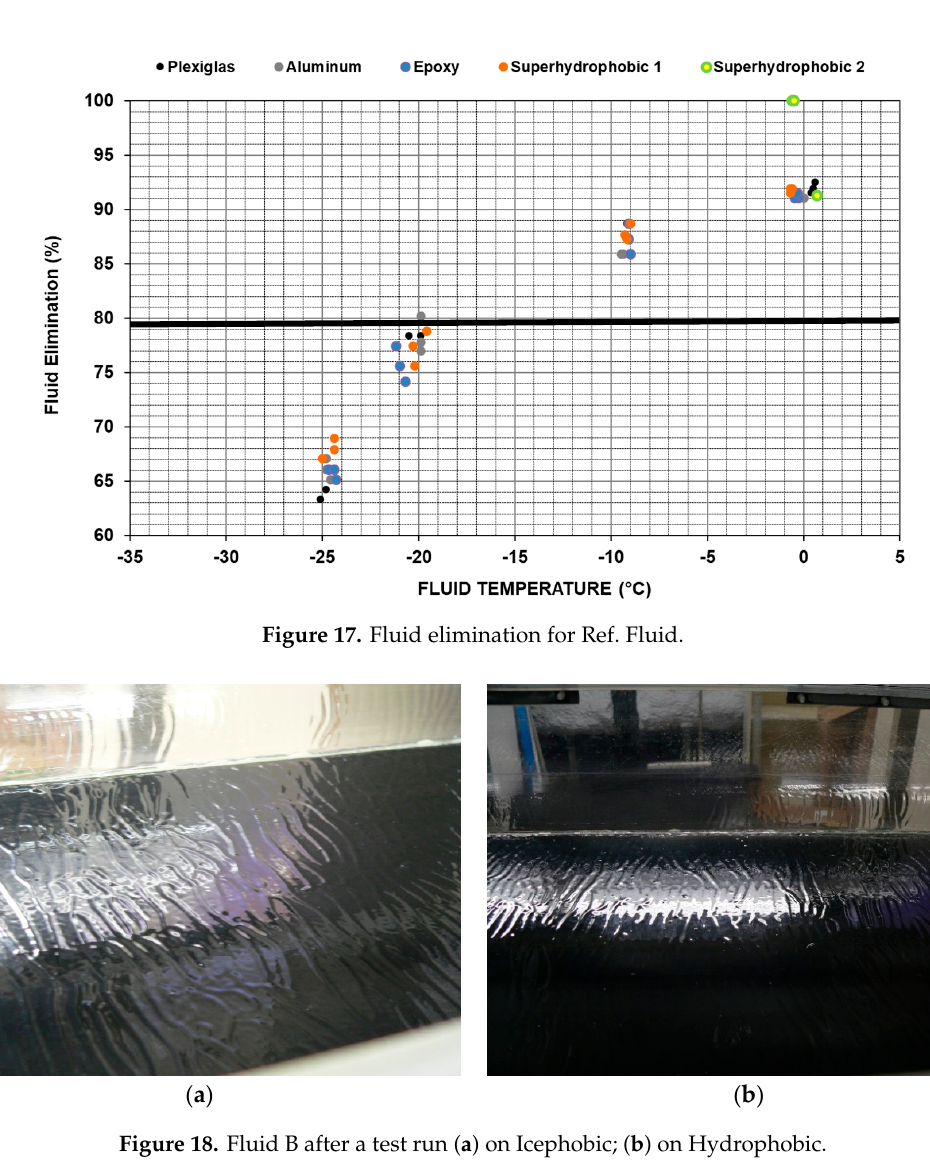
Figure 18. Fluid B after a test run ( a ) on Icephobic; ( b ) on Hydrophobic. Aerospace 2019 , 6 , x FOR PEER REVIEW